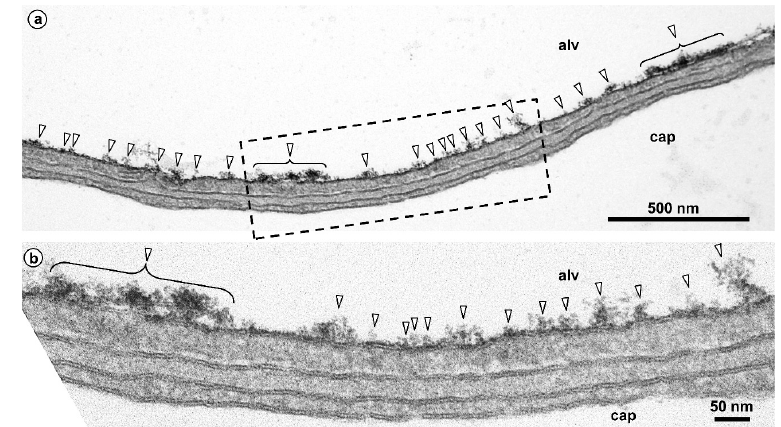
Figure 2. Mouse lung. Glycocalyx staining shown at lower ( a ) and higher ( b ) magnification. Alveolar lumen (alv) and capillary lumen (cap) are separated by the air-blood barrier consisting of a continuous alveolar epithelium, an interstitium and a continuous capillary endothelium. Here, a thin portion of the air-blood barrier is shown. The epithelium is made of thin extensions of alveolar epithelial type I cells. The interstitium is minimized to a common basal lamina shared by epithelium and endothelium. The endothelium is of the non-fenestrated type. The alveolar epithelial surface is clearly stained after treatment with colloidal thorium dioxide (arrowheads). The boxed area in ( a ) is shown in ( b ) at higher magnification.